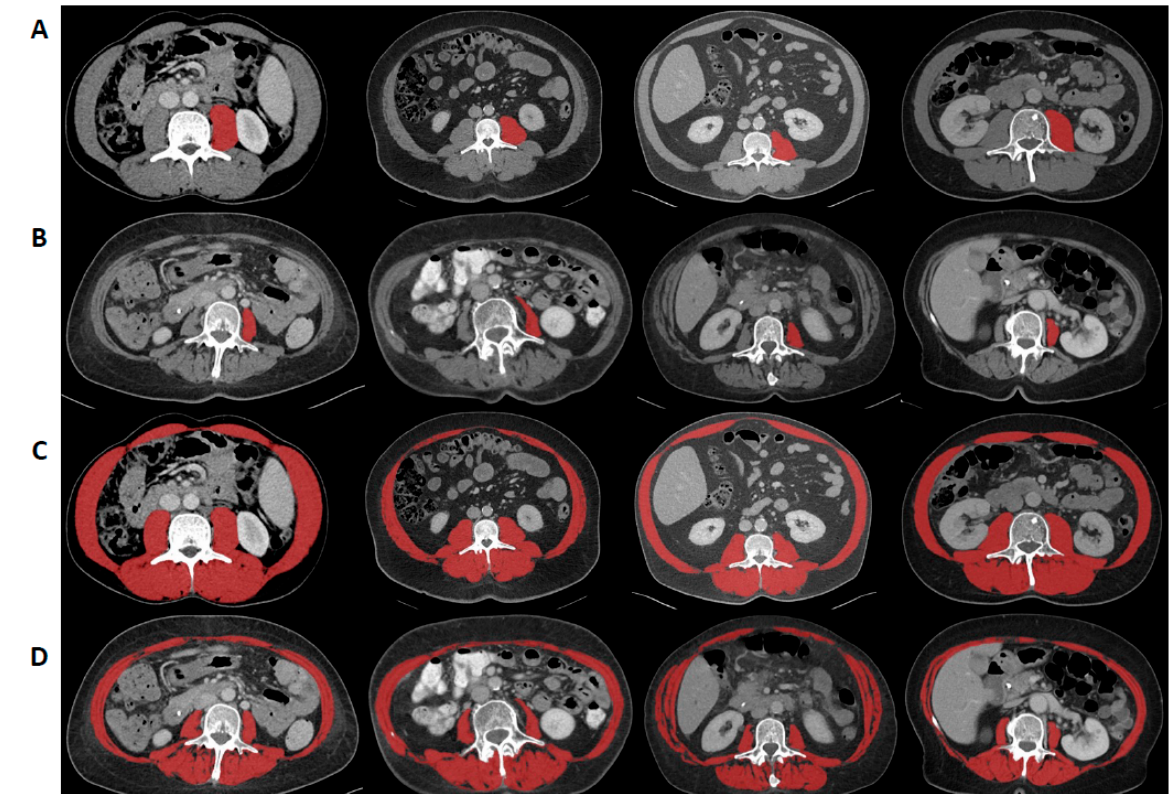
Figure 1. Assessment of the skeletal and the psoas muscle index at level of the third vertebra (L3SMI and L3PMI). L3SMI was assessed by measuring m. psoas, m. erector spinae, m. quadratus lumborum, m. rectus abdominis, m. transversus abdominis, m. obliquus abdominis internus, and m. obliquus abdominis externus in a single slice at the level of the third vertebra using the 3D Slicer and normalizing it to the patient’s height. For L3PMI only the left m. psoas was measured and normalized to the patient’s body height. Examples for high ( A , C ) and low ( B , D ) L3PMI and L3SMI values.